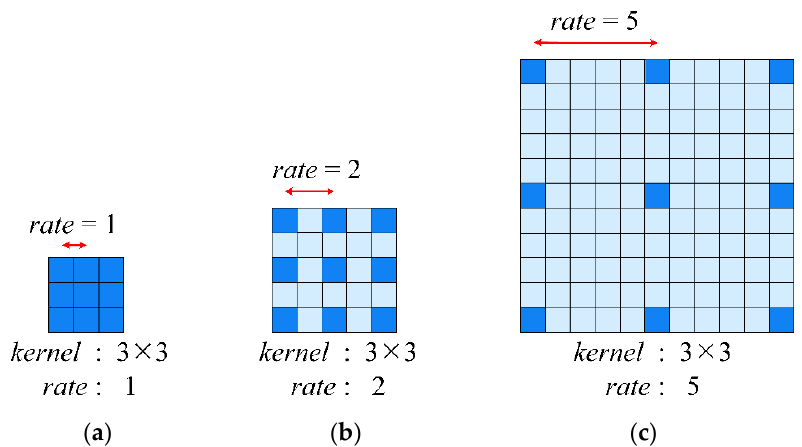
Figure 2. Illustration of the dilated convolution. ( a ) dilated convolution layer when rate = 1. ( b ) dilated convolution layer when rate = 2. ( c ) dilated convolution layer when rate = 5.